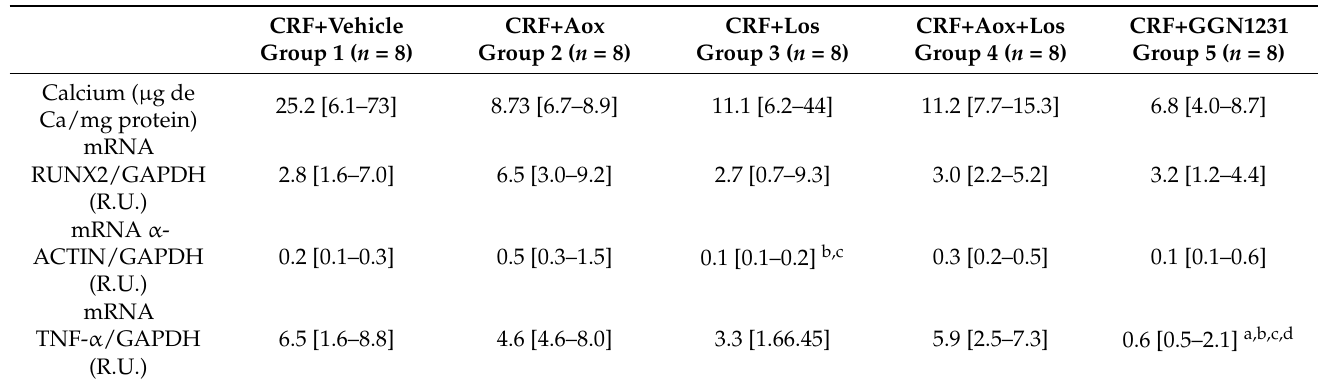
Table 2. Vascular and inflammation parameters.